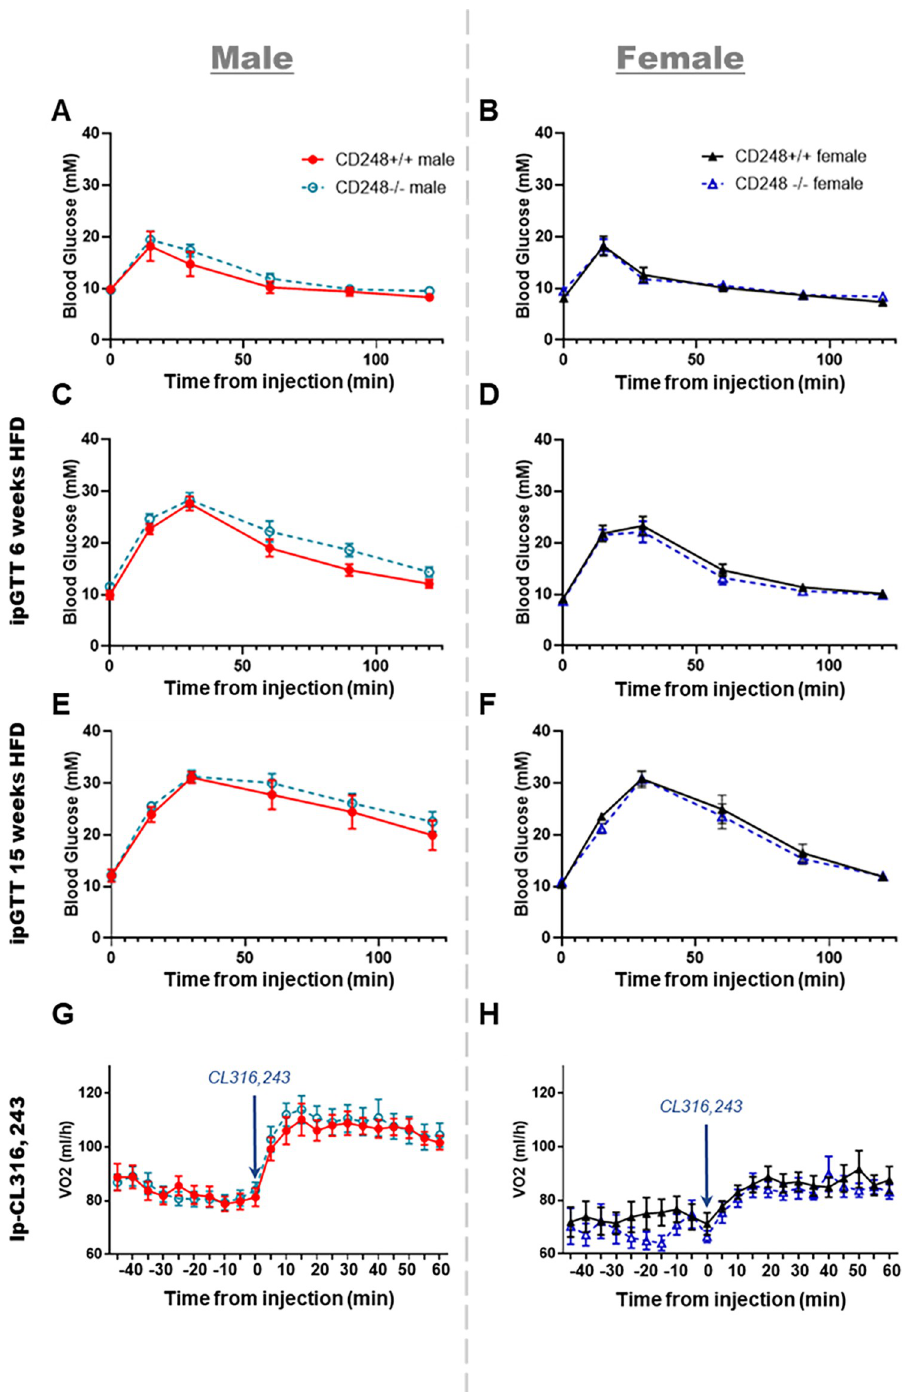
Fig 3. Glucose tolerance test (GTT) was performed at baseline in (A) males and (B) females (6–8 weeks old mice) and following high fat diet-feeding for 6 weeks (C) males and (D) females, then 15 weeks (E) males and (F) females. Response to CL316,243 injection was measured as average VO2 over time in (G) males and (H) females. In all graphs: Cd248 +/+ males (red), Cd248 -/- males (cyan), Cd248 +/+ females (black), Cd248 -/- females (blue). Data were analysed for significant differences by ANOVA. No significant differences were found. All error bars ±